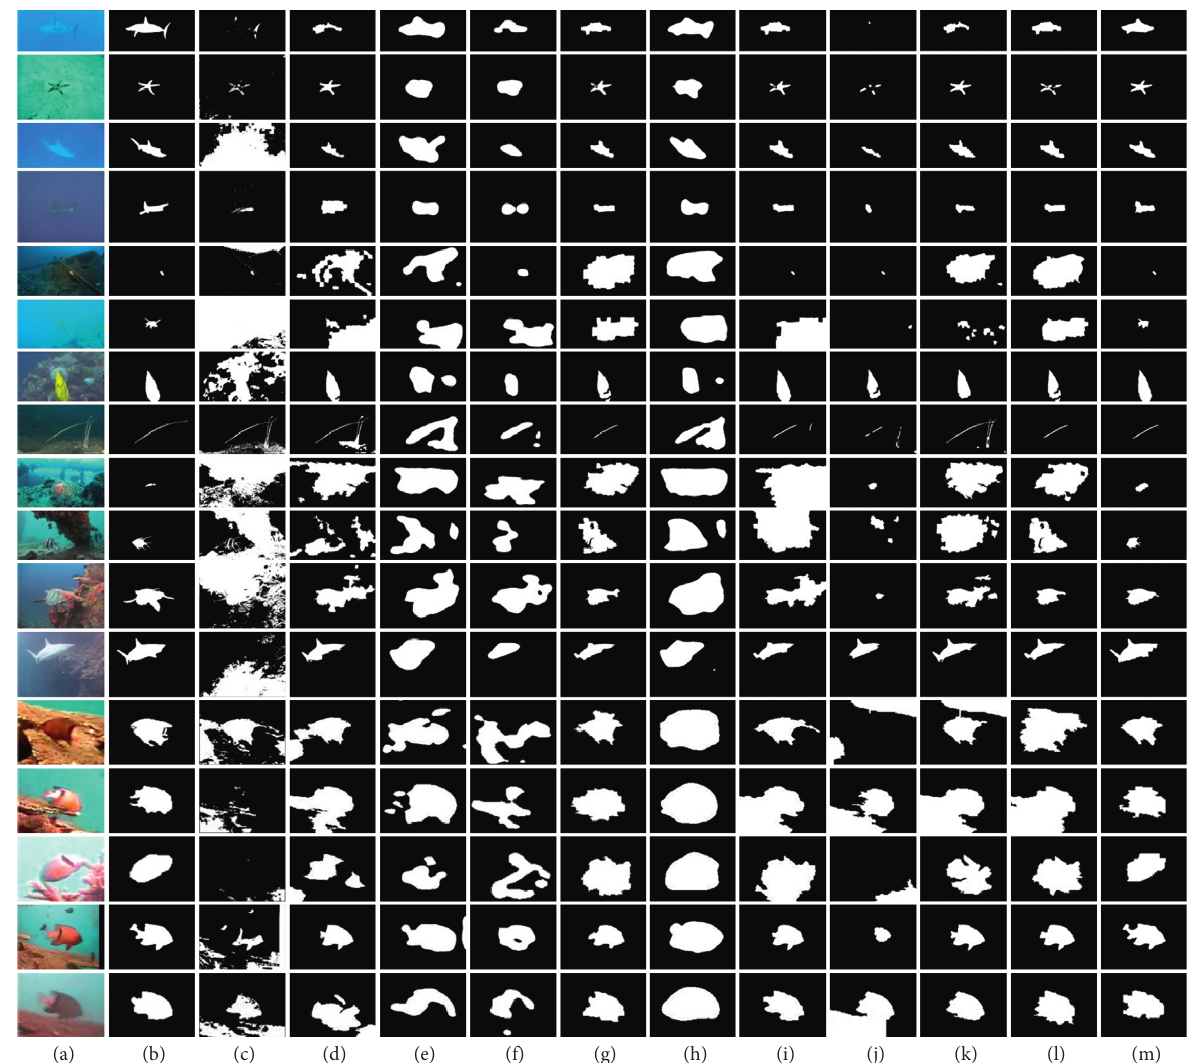
Figure 6: Result comparison. (a) Underwater sample. (b) Ground truth. (c) PCNN. (d) Graph. (e) Itti. (f) HFT. (g) MR. (h) GBVS. (i) PBS.